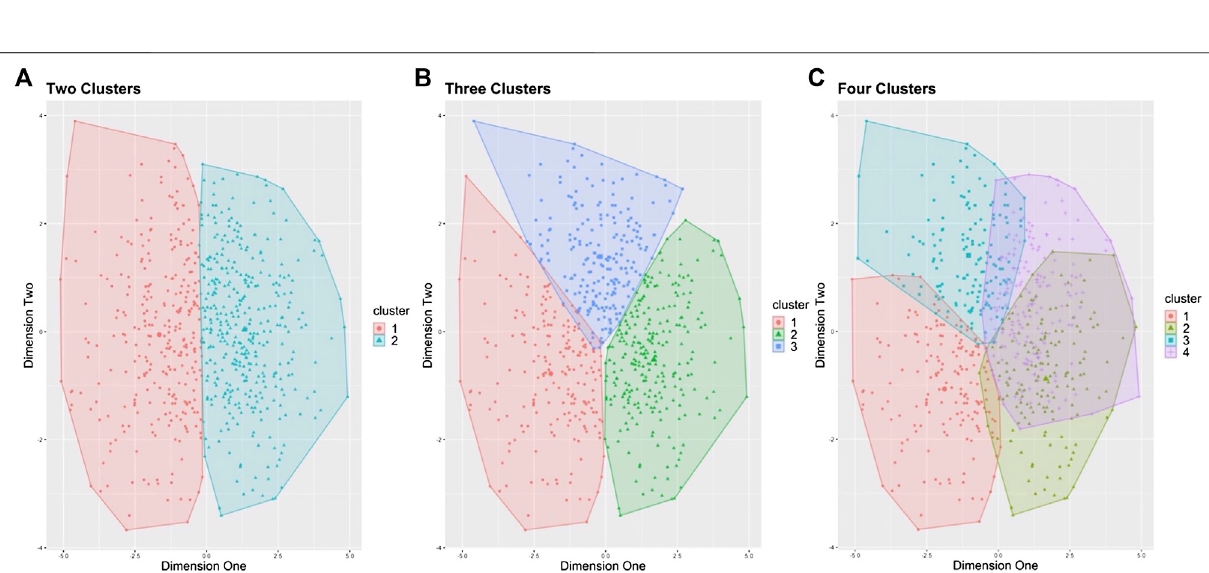
FIGURE 3 | Elbow plot demonstrating, y-axis = total within sum of squares by x-axis = number of clusters (k); Subjective evaluation for number of clusters chosen for analysis, used for determination of k; “ Kink ” in curve occurs at k = 2 and 3.